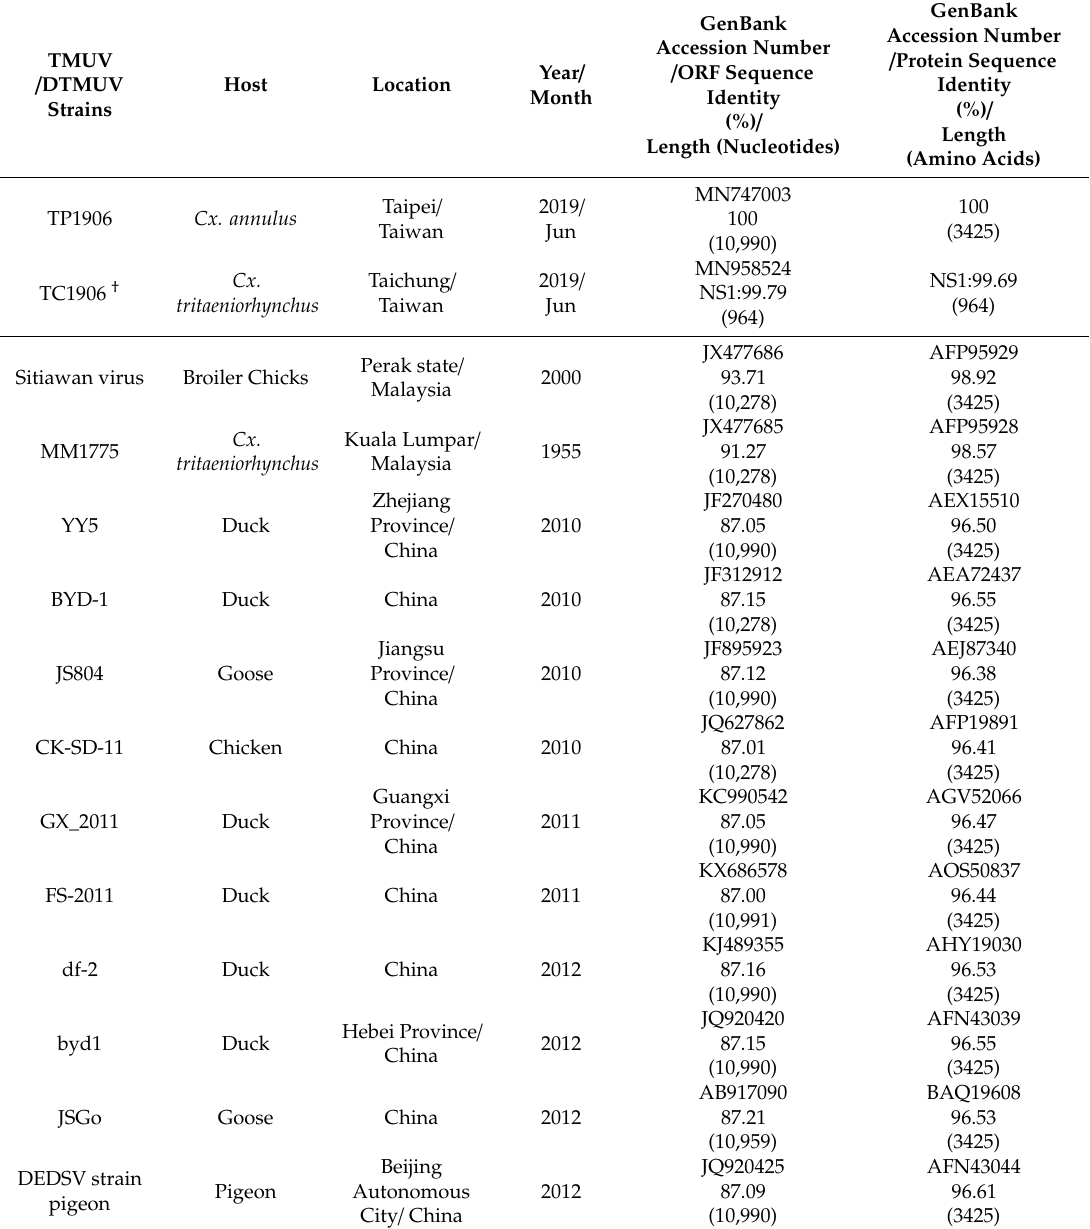
Table 2. Tembusu virus strains used for phylogenetic analysis in this